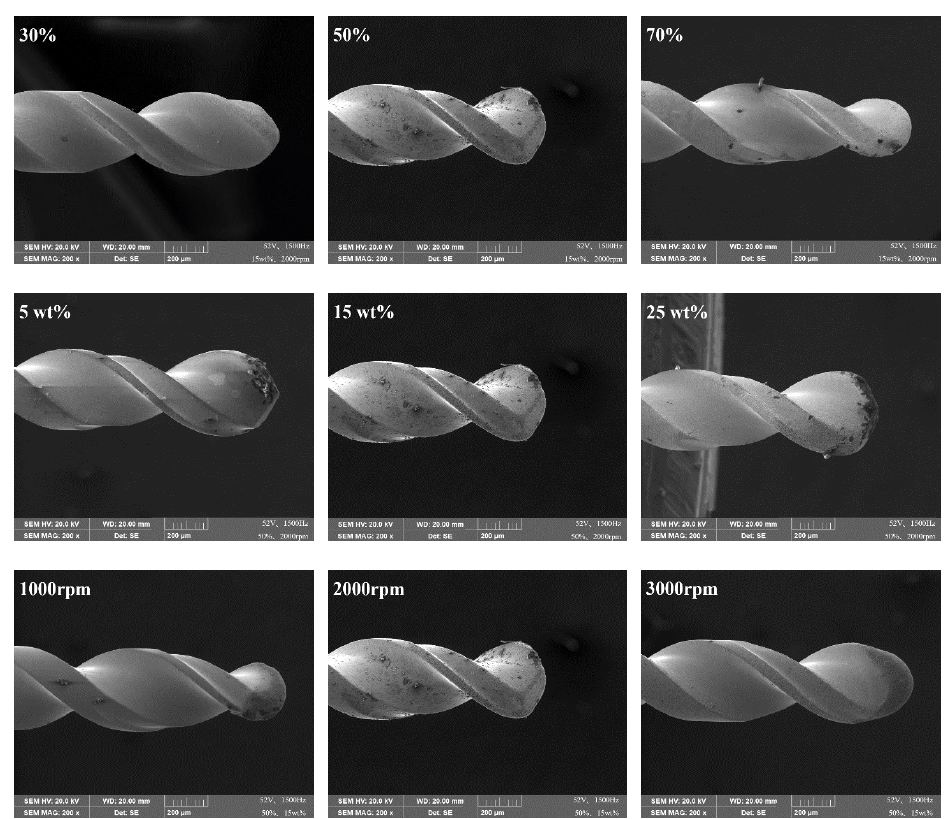
ff erent experimental parameters. Appl. Sci. 2020 , 10 , x FOR PEER REVIEW